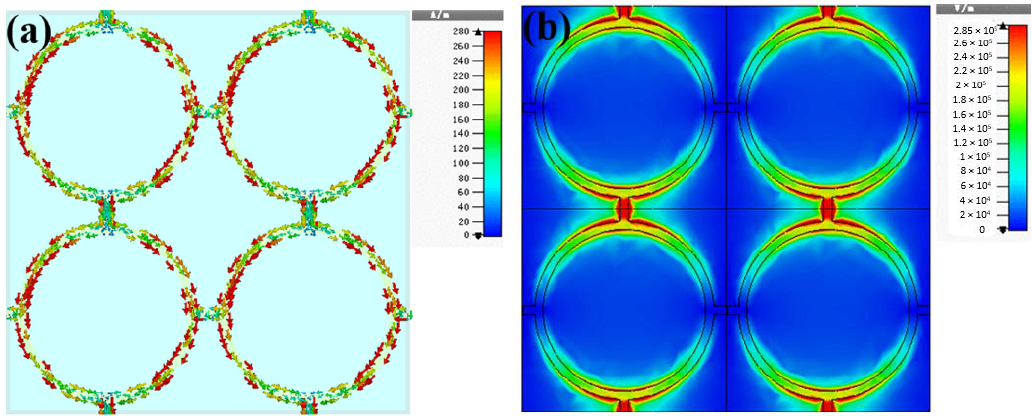
Figure 6. Distributions of ( a ) surface current and ( b ) electric field at resonant frequency.